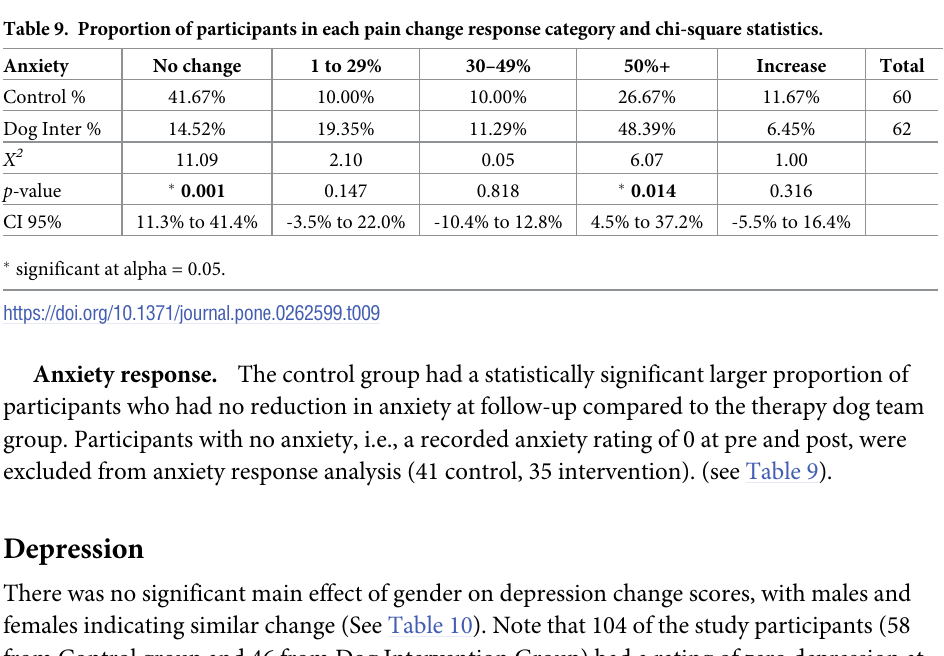
Note .—MS = Mean squares, effect size = partial η 2 .